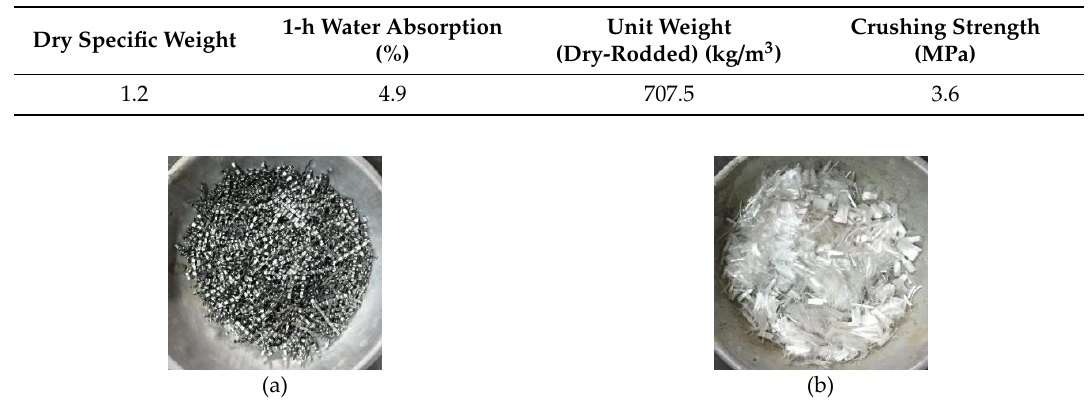
Table 4. Basic properties of fibers. Table 3. Physical and mechanical of lightweight aggregates.